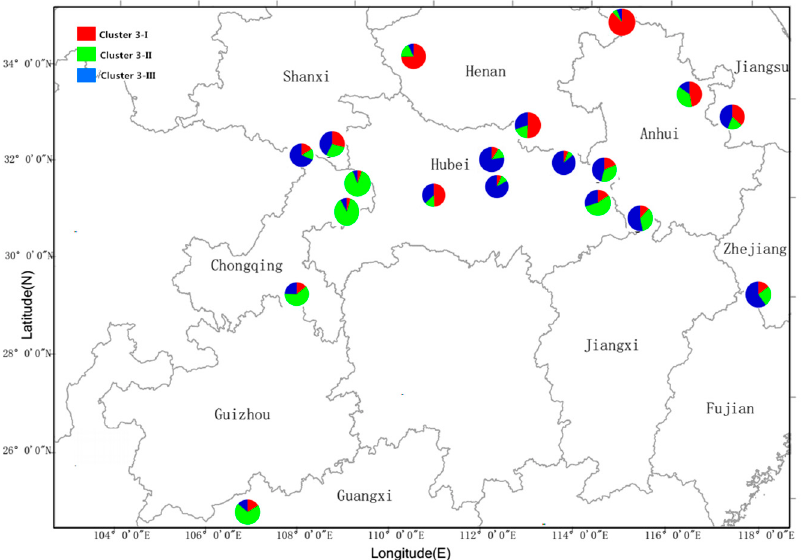
Figure 5. Mean proportions of cluster memberships of analyzed individuals in each of the 19 Q. variabilis populations, based on STRUCTURE analysis at K = 3.